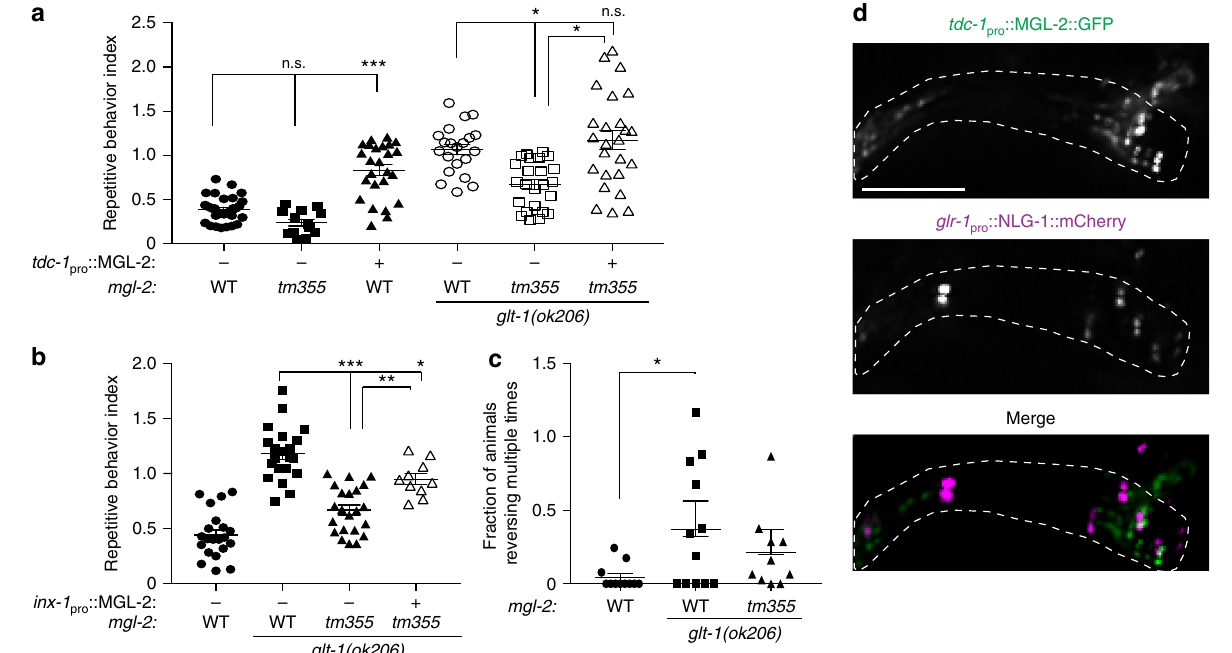
Fig. 5 Glutamate spillover induces repetitive reversals by presynaptic activation of MGL-2. a mgl-2 mutation ameliorates increased repetitive reversals of glt-1 mutants. The effect is reversed by re-expression of MGL-2 speci fi cally in RIM neurons (Kruskal − Wallis ANOVA with Dunn ’ s multiple comparison test, n.s., nonsigni fi cant, *** p < 0.0005, * p < 0.05; WT, black circles, n = 30, mgl-2(tm355) , black boxes, n = 13, tdc-1 pro ::MGL-2, black triangles, n = 25, glt-1 (ok206) , open circles, n = 21, glt-1(ok206) ; mgl-2(tm355) , open boxes, n = 24, glt-1(ok206) ; mgl-2(tm355) ; tdc-1 pro ::MGL-2, open triangles, n = 25 movies). b MGL-2 expression in AIB neurons rescues repetitive reversals (WT, black circles, n = 21, glt-1(ok206) , black boxes, n = 21, glt-1(ok206) ; mgl-2(tm355) , black triangles, n = 22, glt-1(ok206) ; mgl-2(tm355) ; inx-1 pro ::MGL-2, open triangles, n = 10 movies). c Channelrhodopsin activation of RIM promotes GLT-1- mediated repetitive reversals (WT, black circles, n = 11, glt-1(ok206) , black boxes, n = 12, glt-1(ok206) ; mgl-2(tm355) , black triangles, n = 10 movies). a – c Bars, mean ± SEM. b , c ANOVA Tukey ’ s HSD post hoc test, *** p < 0.0005, * p < 0.05. In ( c ), while not signi fi cant at the level of p < 0.05, the trend towards fewer repetitive events in animals also lacking mgl-2 is consistent with our observations in (a, b). d GFP-tagged MGL-2 localizes to RIM neurite (left), but not to mCherry-labeled synapses (middle); merge (right). Scale bar, 5 μ m; nerve-ring region is indicated with dotted line; 2- μ m-thick sum